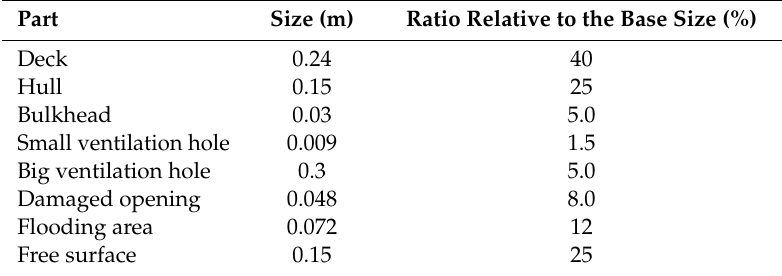
Table 5. Mesh sizes in di ff erent parts.